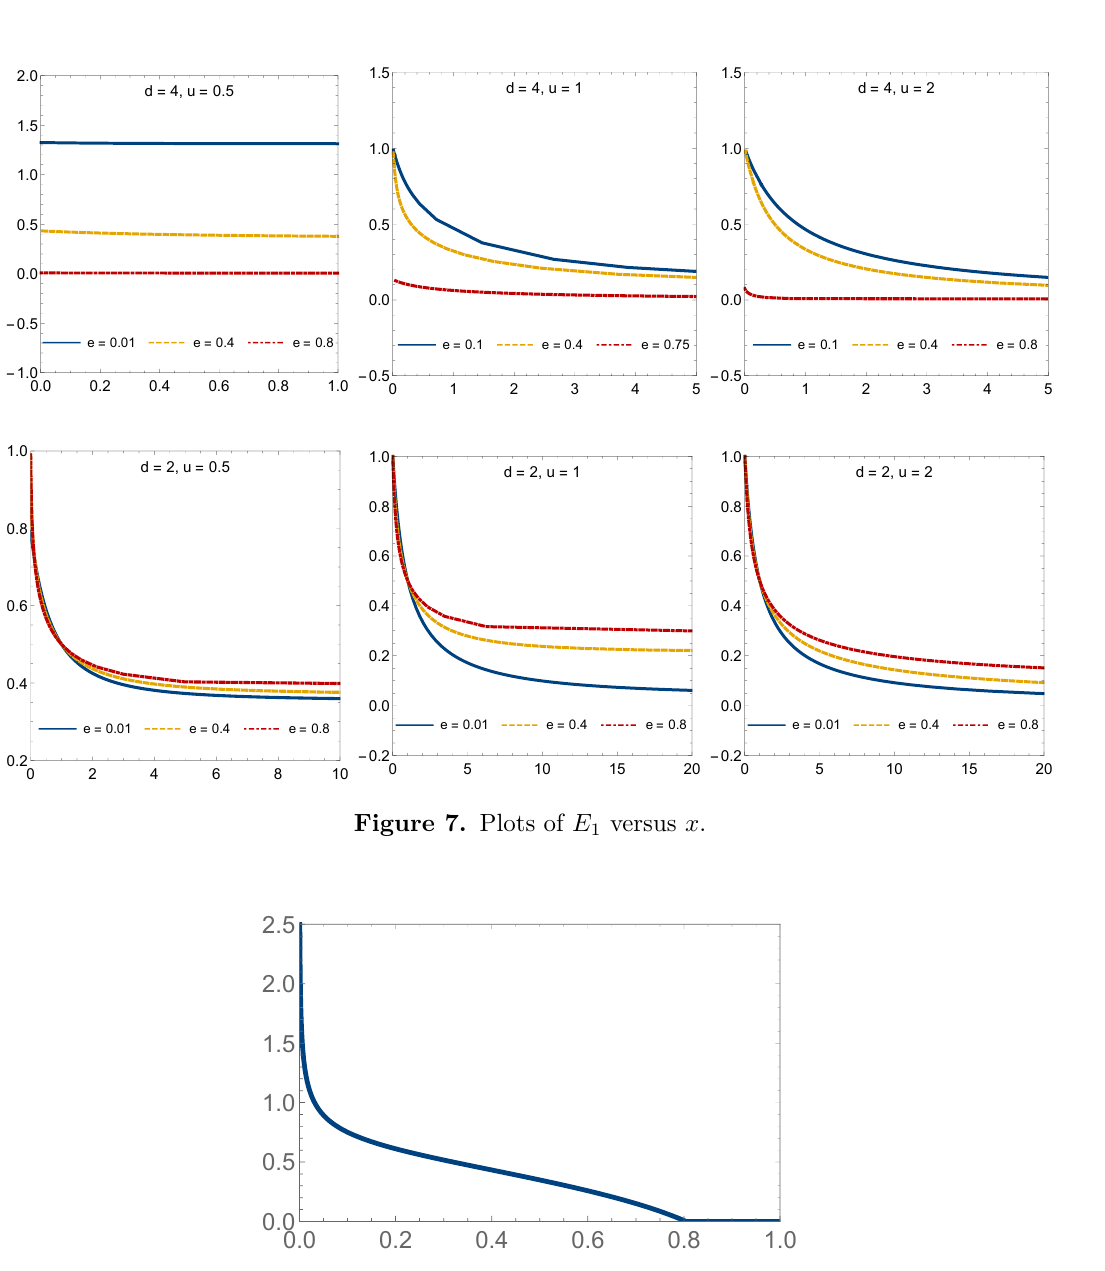
Figure 8. Plot of the maximum value of E 1 , E max , as a function of e for d = 4 and u = 0 . 5 . Note 1 that E max → ∞ as e → 0 , and E max = 0 for e larger than some critical 1 1